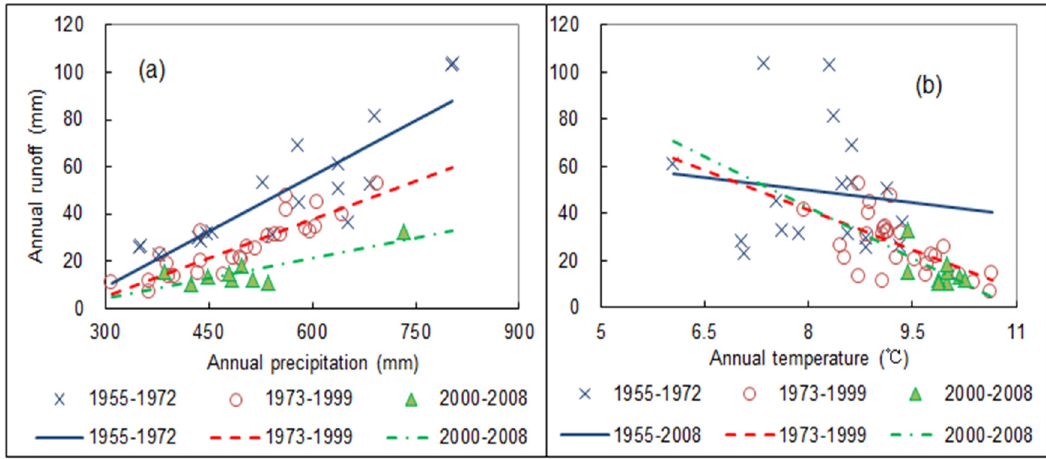
Figure 8. ( a ) Relationships of annual runoff against annual precipitation; ( b ) temperature.